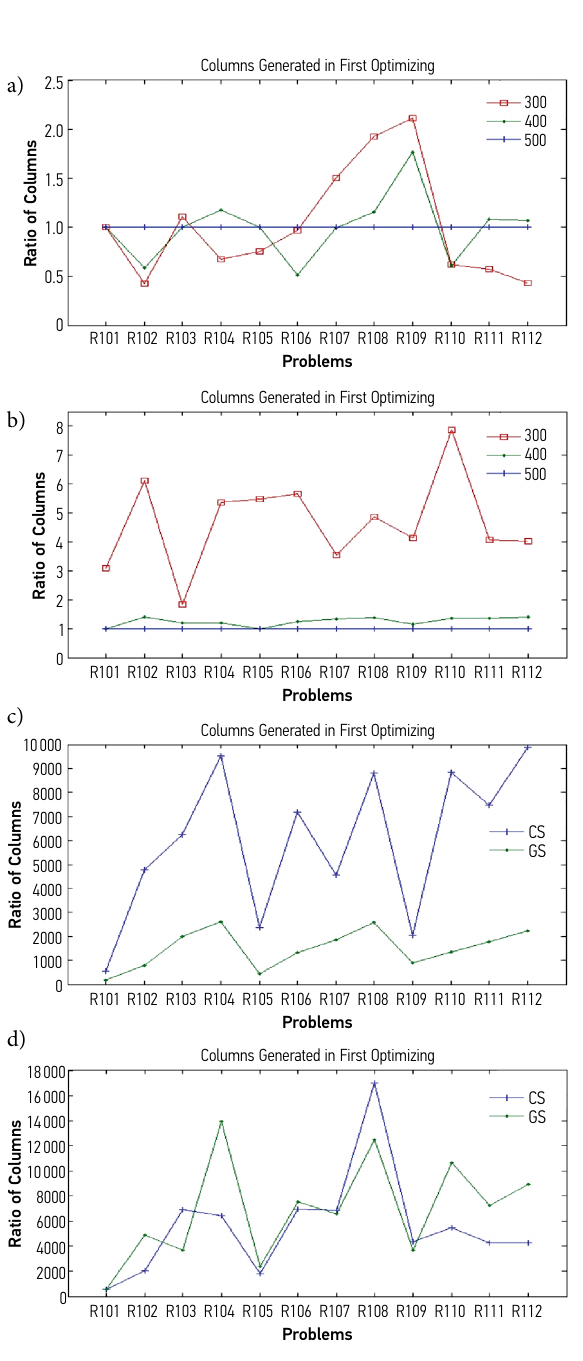
Fig. 3. Comparison of iteration number under different condition and searching number: a – iteration number under CS; b – iteration number under GS; c – iteration number under searching time 500; d – iteration number under searching time